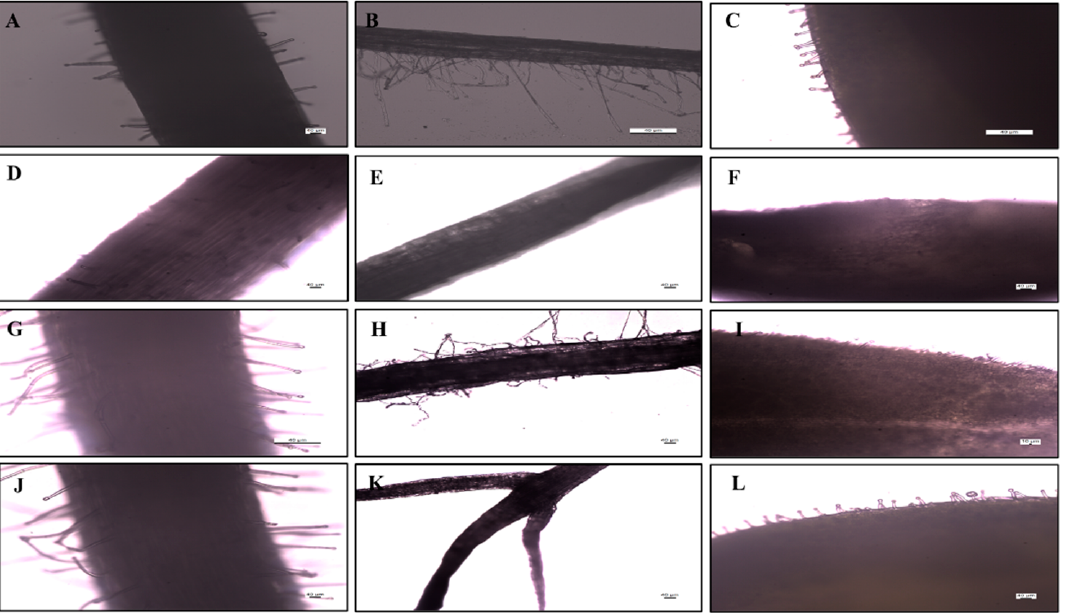
Figure 8. Microscopic images of the control plant ( A ) Shoot, ( B ) Root, ( C ) Leaf, PS-interacted plant ( D ) Shoot, ( E ) Root, ( F ) Leaf, HA-interacted plant ( G ) Shoot, ( H ) Root, ( I ) Leaf and PS + HA inter- acted plant ( J ) Shoot, ( K ) Root, ( L ) Leaf.